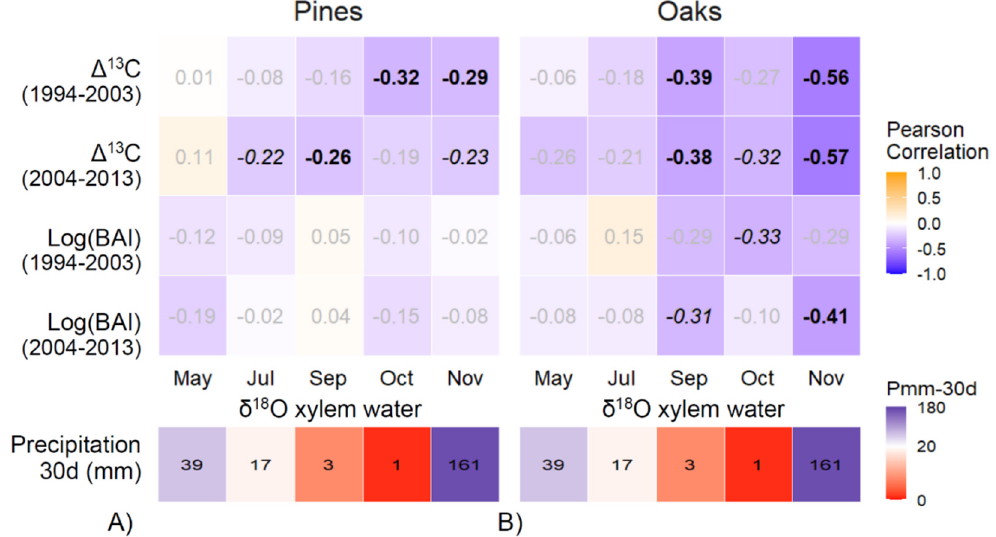
Figure 4. Weighted simple (Pearson) correlation coefficients between either Δ 13 C or log-transformed BAI (corresponding to a wet (1994-2003) or a dry decade (2004-2013)) and seasonal values of δ 18 O of xylem water measured during a drought and recovery cycle in 2011. ( A ) Pines; ( B ) oaks. Correlations with p < 0.05 and p < 0.10 are highlighted in bold and italics, respectively. As a reference for water status, accumulated precipitation during the 30 days (Pmm-30d) preceding each xylem water sampling (dates: 26 May, 20 July, 9 September, 19 October, and 18 November 2011) is shown in the bottom panels.